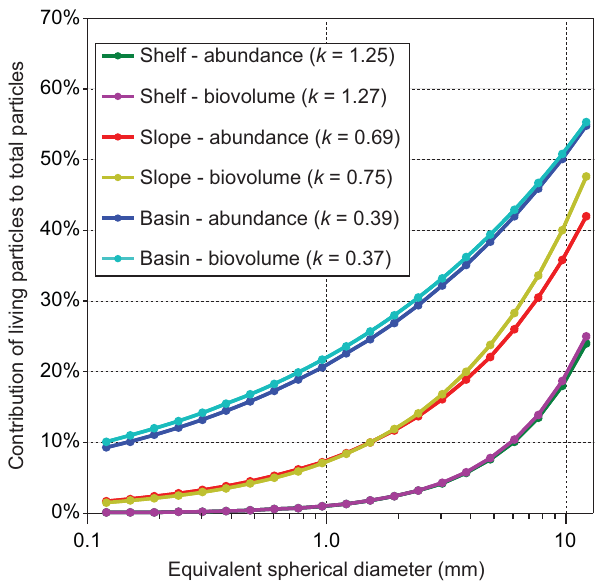
Fig. 4. Contribution of living particles (i.e. plankton) to total par- ticle abundance and biovolume across the three target regions as estimated with the power-law equations derived from the normal- ized particle size distributions acquired with the Underwater Vision Profiler (Fig. 3). This figure aims at showing the idealized percent- age of planktonic particulates in the total particle inventory as a function of size expressed in terms of equivalent spherical diameter (ESD). The k value of each curve represents the scaling exponent of the power-law regression (i.e. slope in log-log scale) between the percent contributions of living particles and the various size